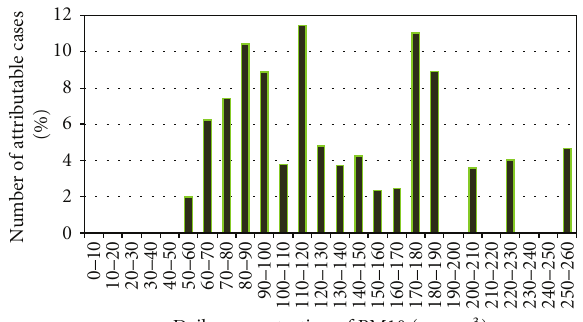
Figure 12: Distribution of the number of attributable cases (%) by PM10 concentration classes in